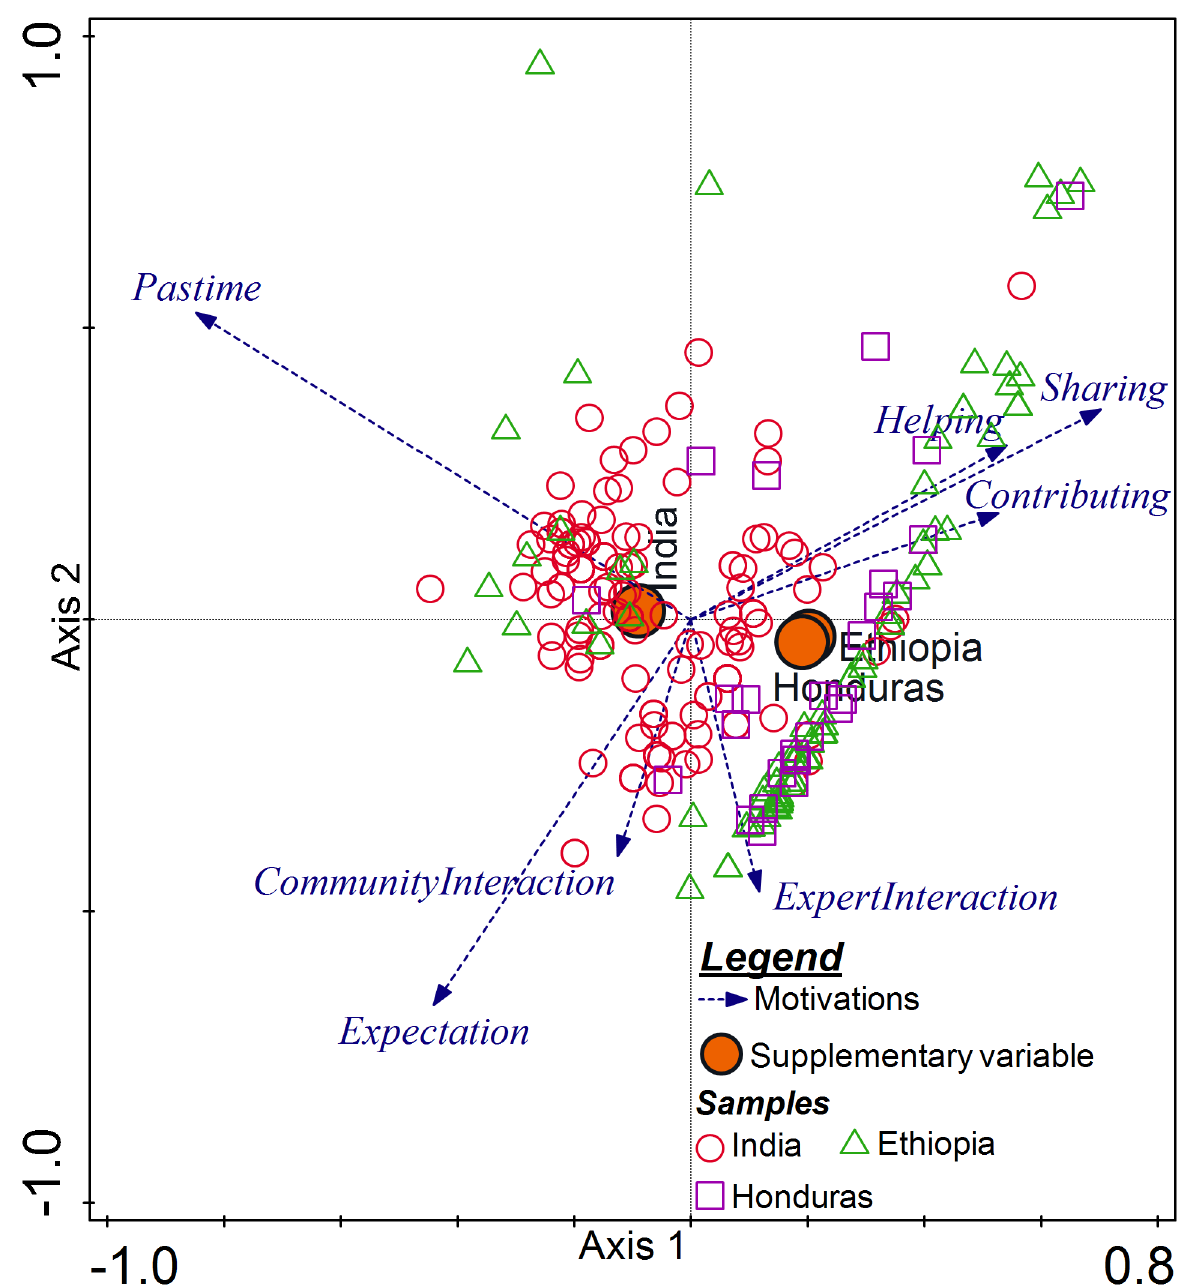
Fig 3. Triplot diagram showing the result of the PCA analysis of motivational factors using country as a supplementary variable (filled circle) together with samples from the three countries. The blue (dashed) vectors represent motivational factors. The circles (unfilled),trianglesand squares represent samples from India, Ethiopiaand